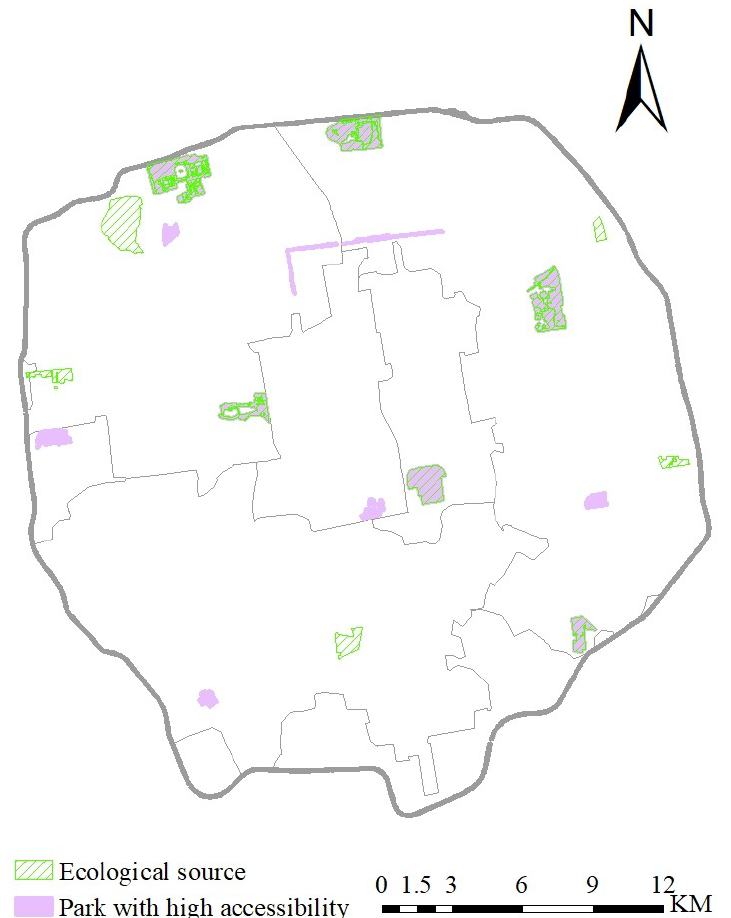
Figure 10. Comparison of ecological sources and parks having high accessibility.